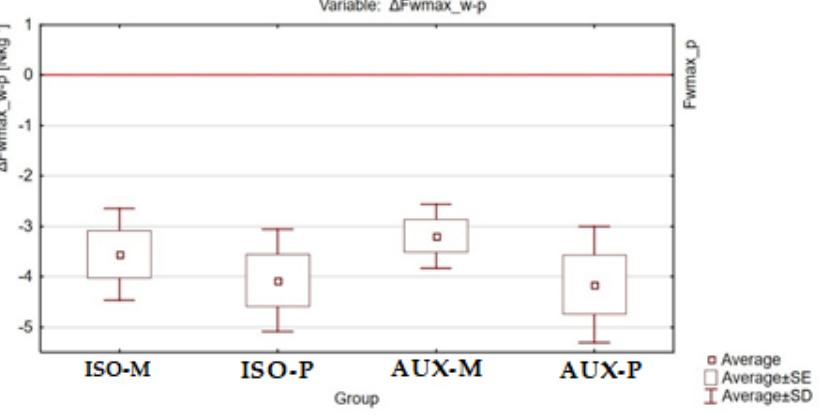
Figure 4. Graphical representation of the results of ANOVA Kruskal–Willis analysis for the ΔFwmax_w-p variable between all tested groups of participants.